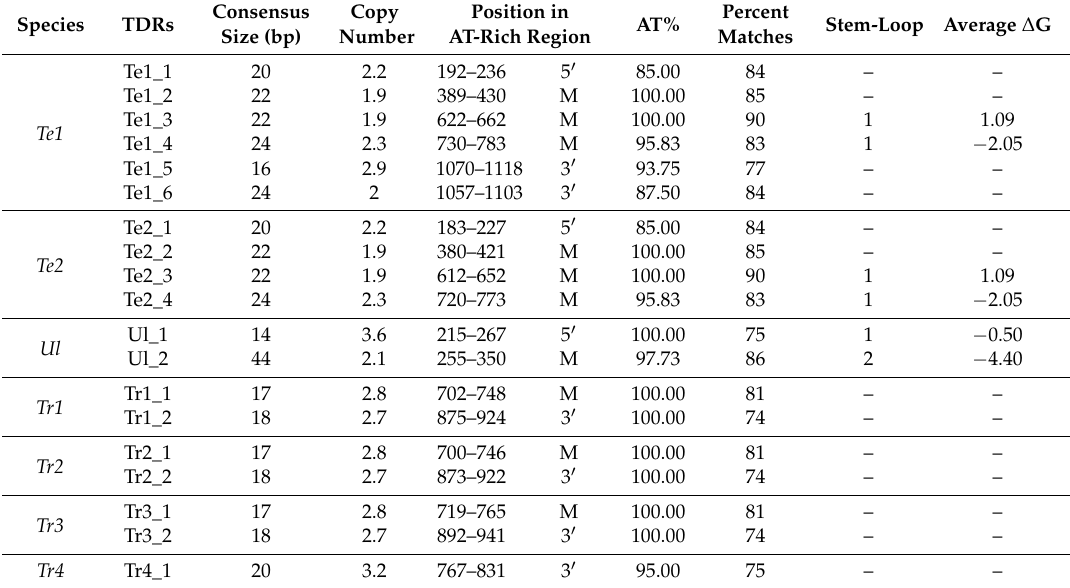
Table 2. Statistics of tandem repeat sequence in the AT-rich region from ten Tenebrionidae mitogenomes. Species